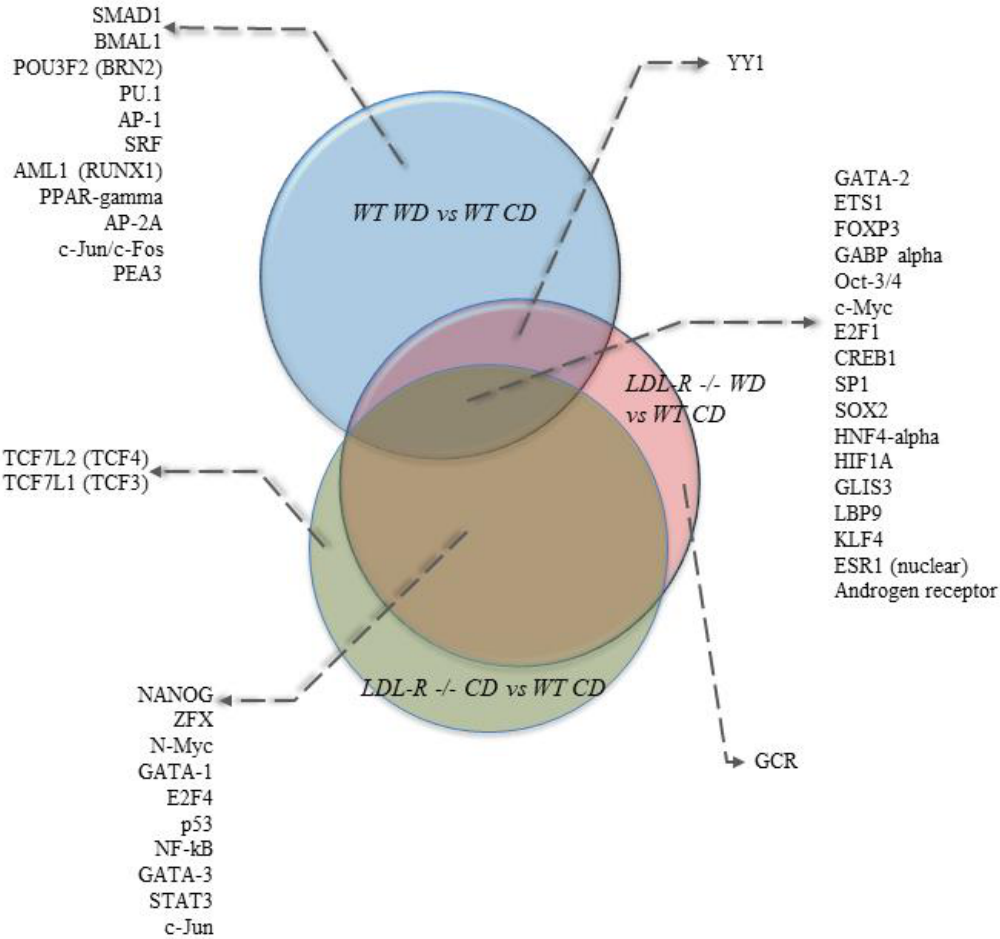
Figure 4. Venn diagram of the top 30 transcription factors a ff ected by diet and genotype in hippocampal microvascular endothelium. Transcription factors potentially modulated by lipid injury were identified using a MetaCore transcription regulation algorithm. Venn diagram shows 17 transcription factors (TFs) in common for the Western diet (WD)-fed C57BL / 6J (WT) mice, control diet (CD)-fed LDL-R − / − mice, and WD-fed LDL-R − / − mice, when compared with the CD-fed WT